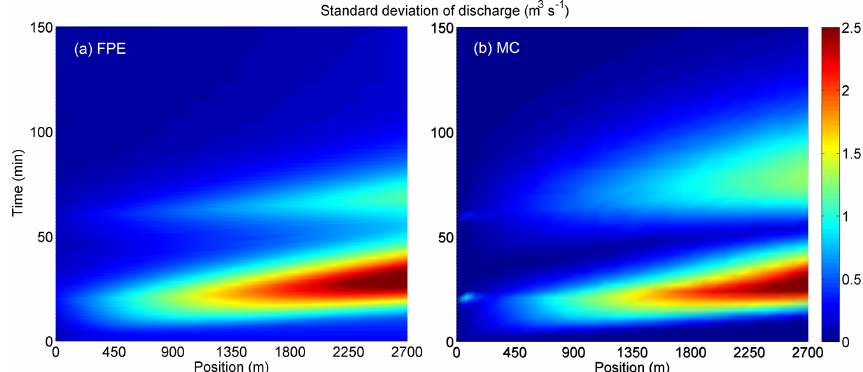
Figure 8. Standard deviation of flow discharge over channel position and time obtained by (a) the FPE methodology and (b) the MC approach.